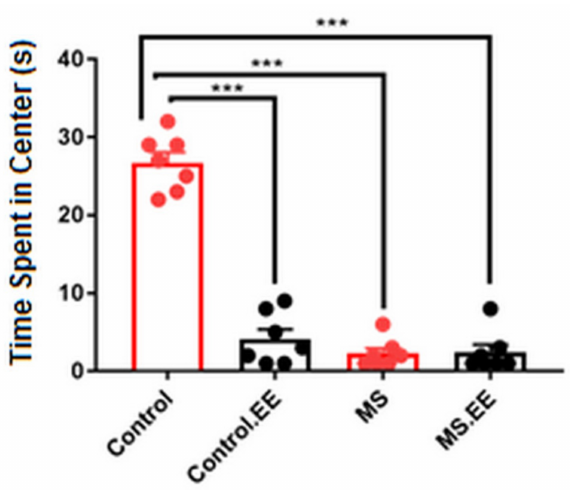
Figure 3. Effects of maternal separation and EE on anxiety behavior in the open field test. *** p < 0.001. N = 10 in each group. MS: Maternal Separation, EE: Environmental